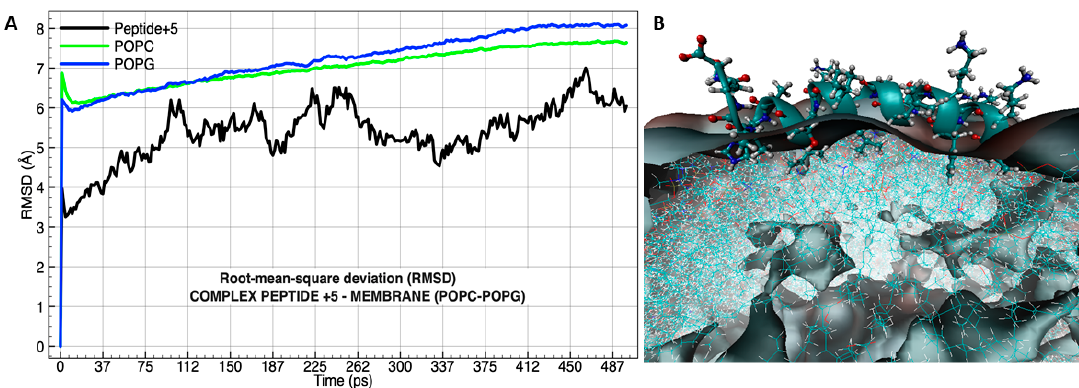
Figure 8. RMSD (root mean square deviation) in 500 ps of molecular dynamic simulation of the peptide + 5 (black) with phospholipids POPG (blue) and POPC (green) ( A ); graphical representation of the peptide + 5 insertion into the membrane (( B ), image taken at 97 ps). Peptide and phospholipids are shown by the graphical representation using CPK coloring convention, the first represented by bonds and the second by lines. The model allows to see the α -helix structure and everything influenced by QuickSurf [53].